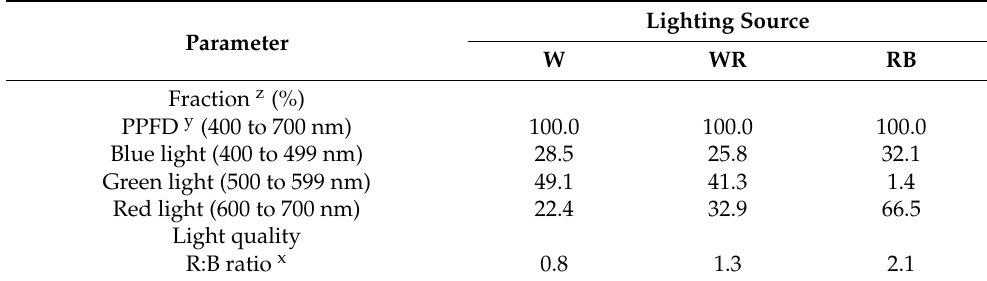
Table 1. The spectral properties of the supplementary white LEDs, white plus red LEDs, and red plus blue LEDs used in this